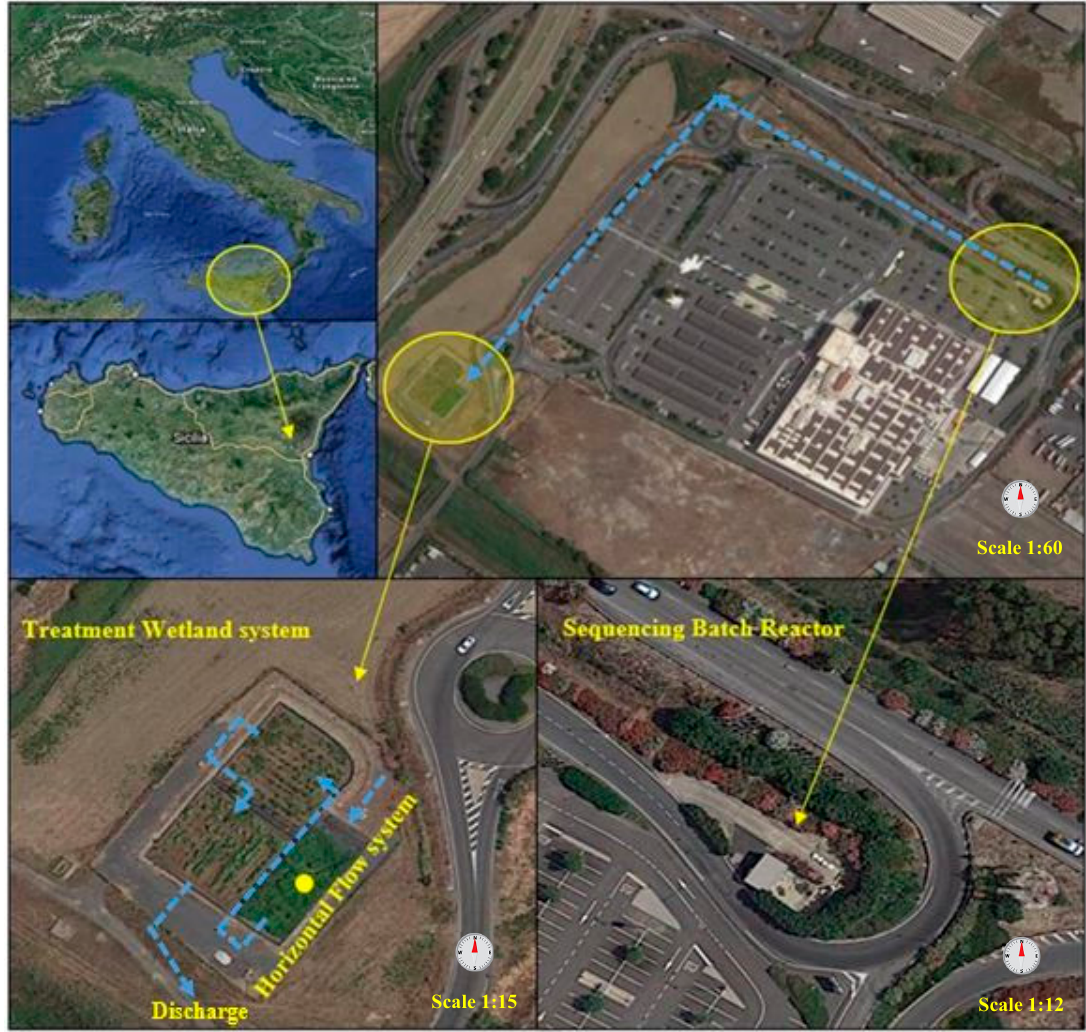
Figure 1. Map of the location area and the hybrid treatment wetland (TW) at the IKEA ® store, located in Catania, Sicily, Italy, showing the water flow routes (in blue).